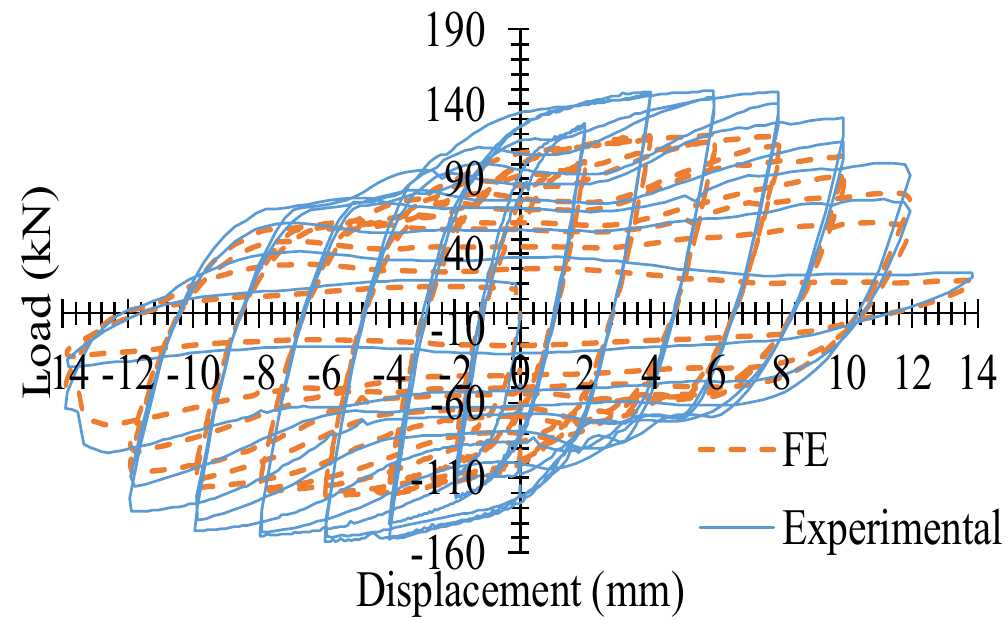
Figure 4. Comparing FE result with experimental test result.